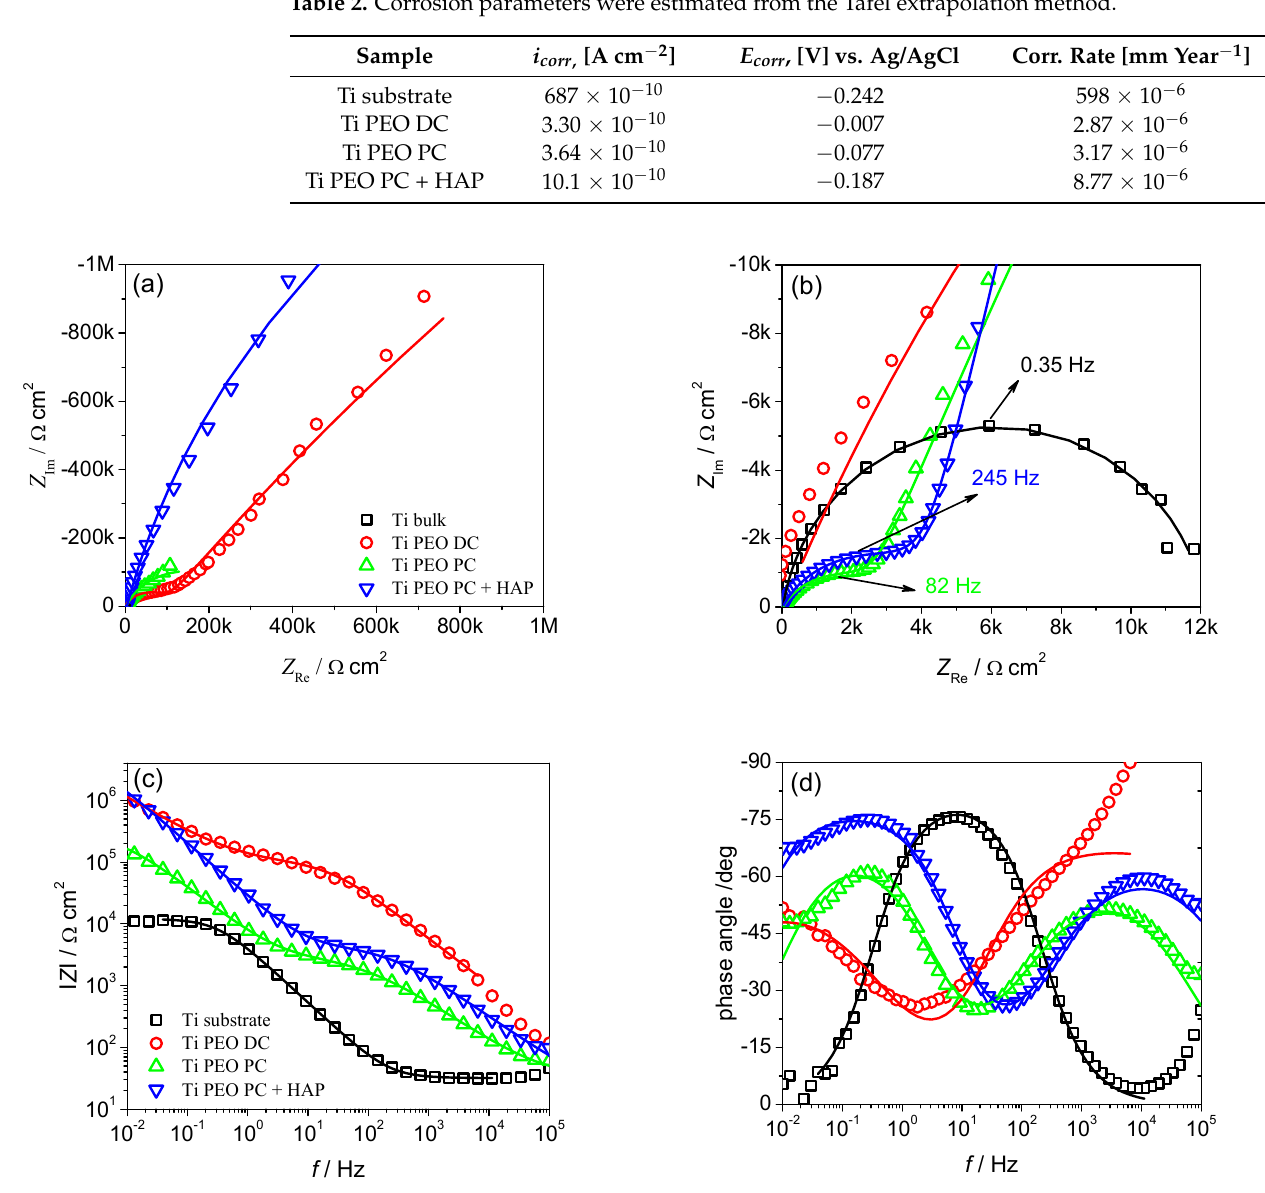
Figure 9. The electrical equivalent circuit was used to model the impedance data of ( a ) untreated titanium substrate and ( b ) PEO-treated titanium.